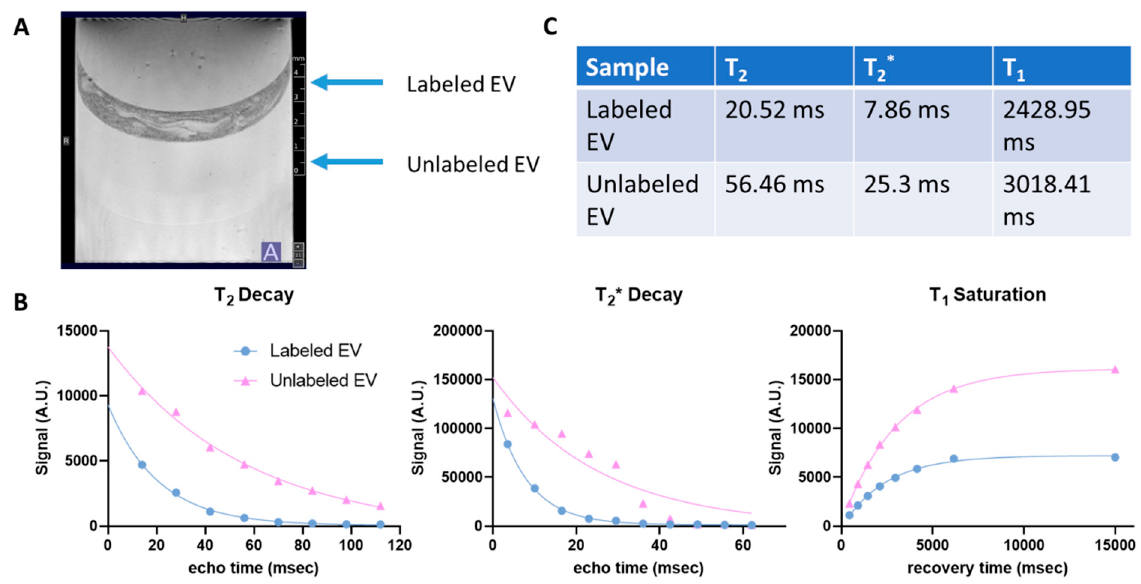
Figure 6. Enhanced in vitro MRI contrast for the labeled brain organoid − EVs (5 nm). ( A ) Labeled EVs were visualized as a mostly homogenous layer with significant contrast compared to unlabeled EVs. ( B ) Decay and saturation curves supported a strong MR contrast with ( C ) reduced T 2 , T 2* and T 1 values for labeled EVs compared to their unlabeled counterparts.